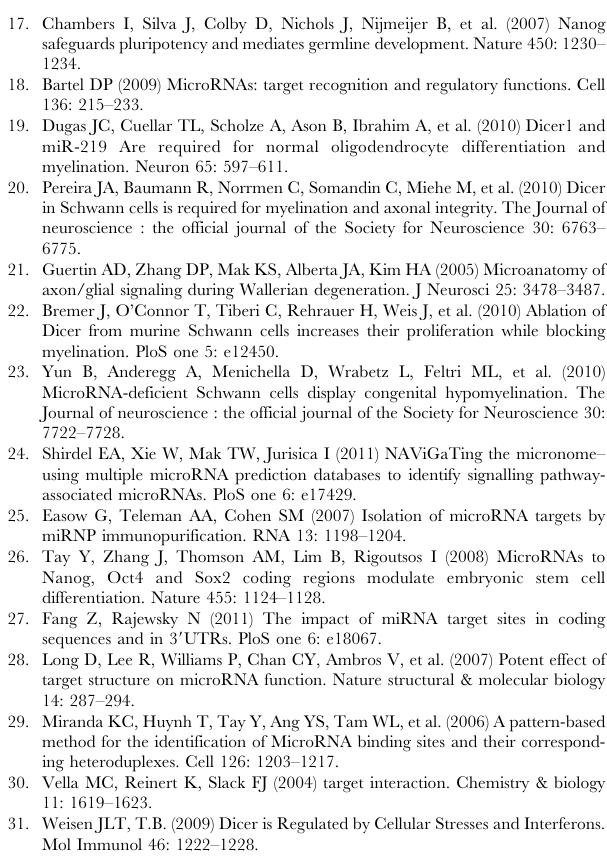
Figure S1 Taqman qRT-PCR analysis of individual microRNAs from control and 24 hour post-injury distal nerves, normalized with U6 snRNA as internal control. Fold difference (2 - DD CT ) between injured versus normal nerves is plotted using standard deviation as error. Figure S2 Mature miRNAs 138, 690, 711 and U6 snRNA loading control were detected by Northern Blotting between control and in injury. Figure S3 Cos-7 cells were transfected with empty pmiR-Report luciferase vector (50 ng) in presence of pCMV-vectors expressing miR-709 or miR-138 or empty pCMV vector and b -Gal report vector (25 ng each).